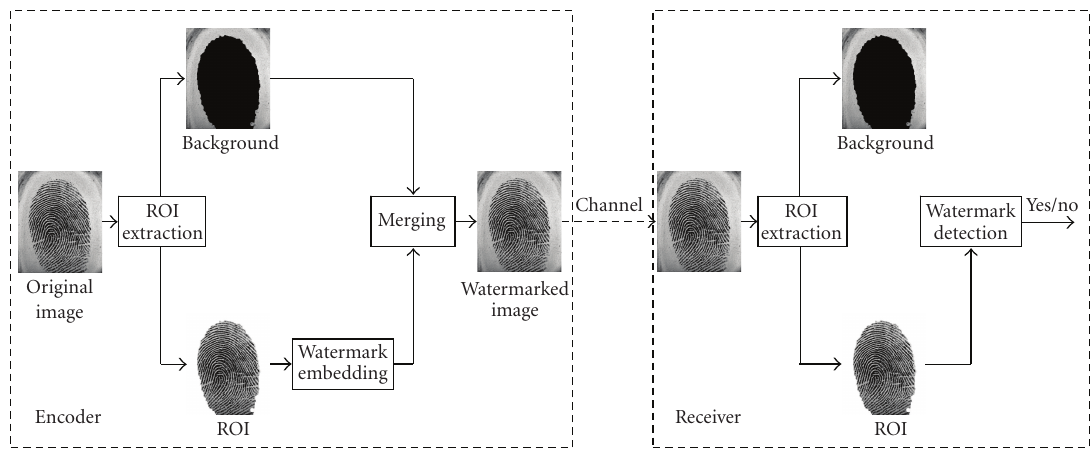
Figure 3: Personalized watermarking system applied to fingerprint images.